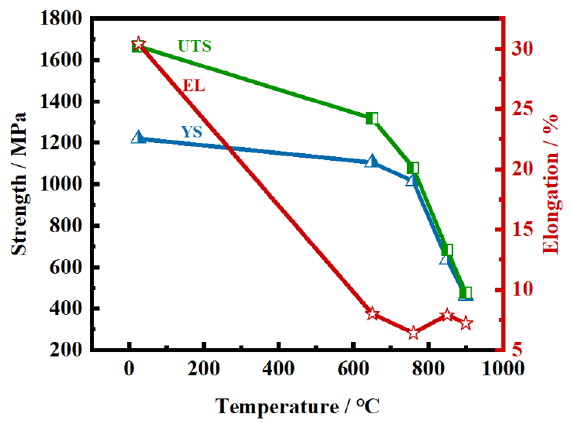
Figure 1. Tensile properties of the superalloy at different temperatures.